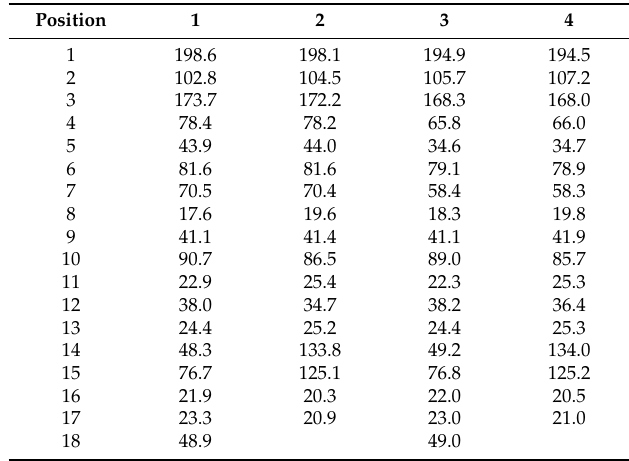
Table 2. 13 C-NMR data of 1 ´ 4 in CDCl 3 at 125 MHz ( J in Hz, δ in